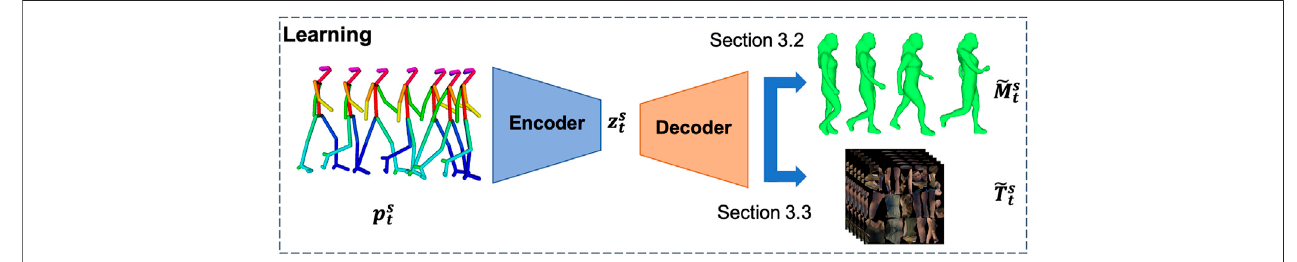
FIGURE 2 | Pose2Shape network overview. The input and the output of the encoder and decoder is 3D skeletal motion and 4D shape respectively.